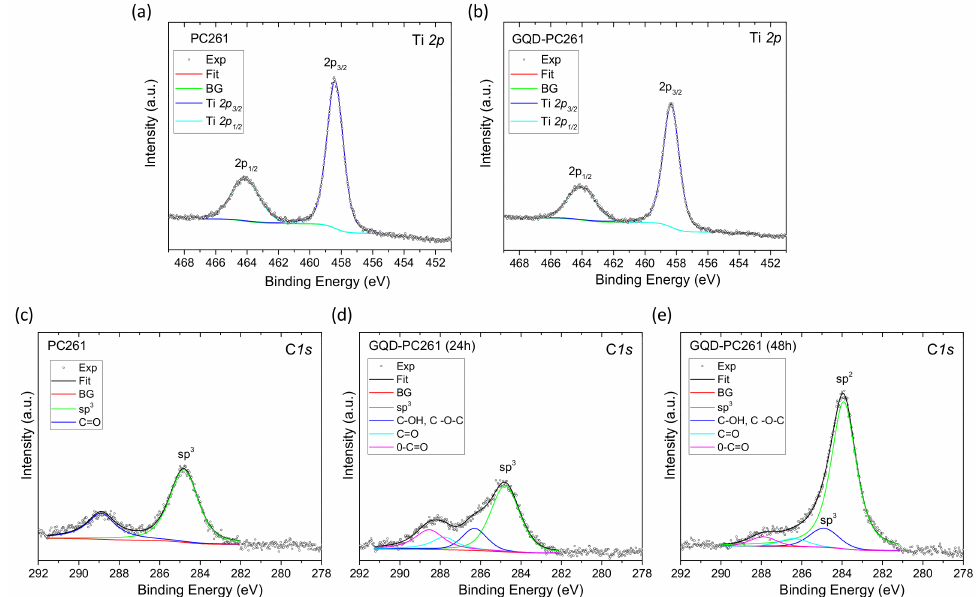
Figure 5. Ti 2p X-ray photoelectron XP spectra for the ( a ) PC261 and ( b ) GQD-PC261 films. C 1s XP spectra for the ( c ) PC261 and ( d , e ) GQD-PC261 films after surface modification for 24 h (48 h) impregnation. Solid lines show the total fit and the individual peak deconvolution. The sp 3 component in ( c , d ) is attributed to adventitious carbon, while in ( e ) the sp 2 component indicates GQDs presence.